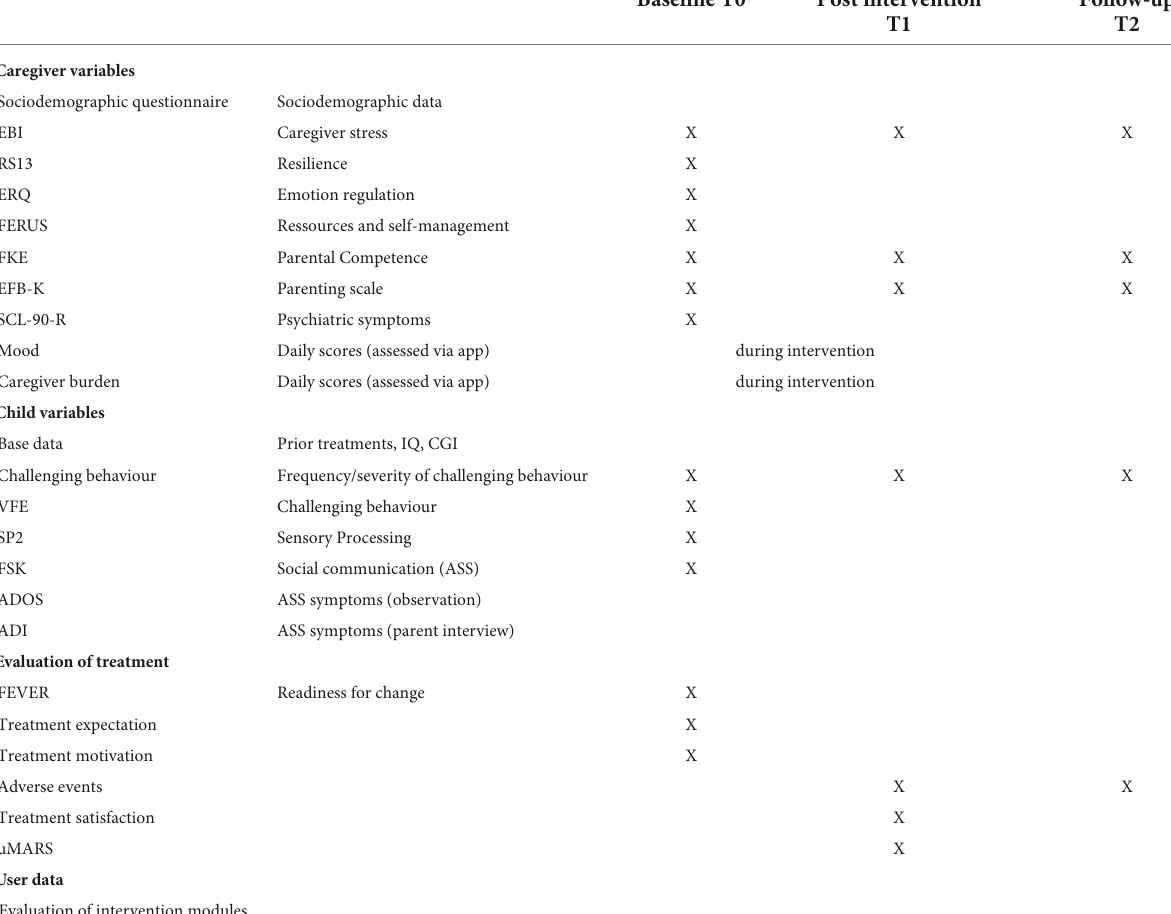
TABLE 2 Instruments and